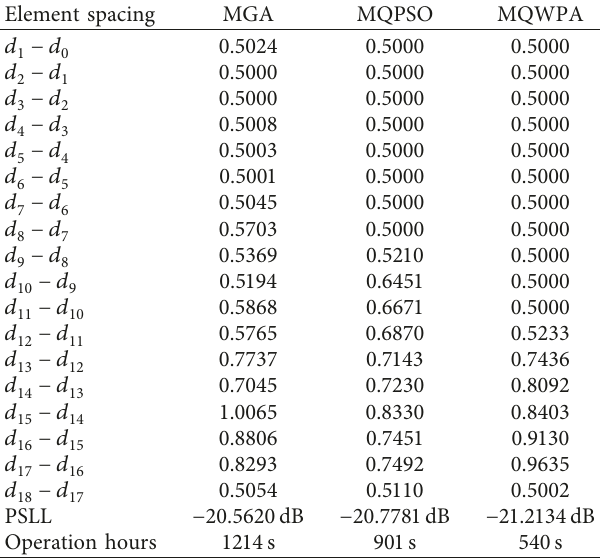
Table 2: Comparison of the best results of three algorithms for optimizing example 2 (unit: λ